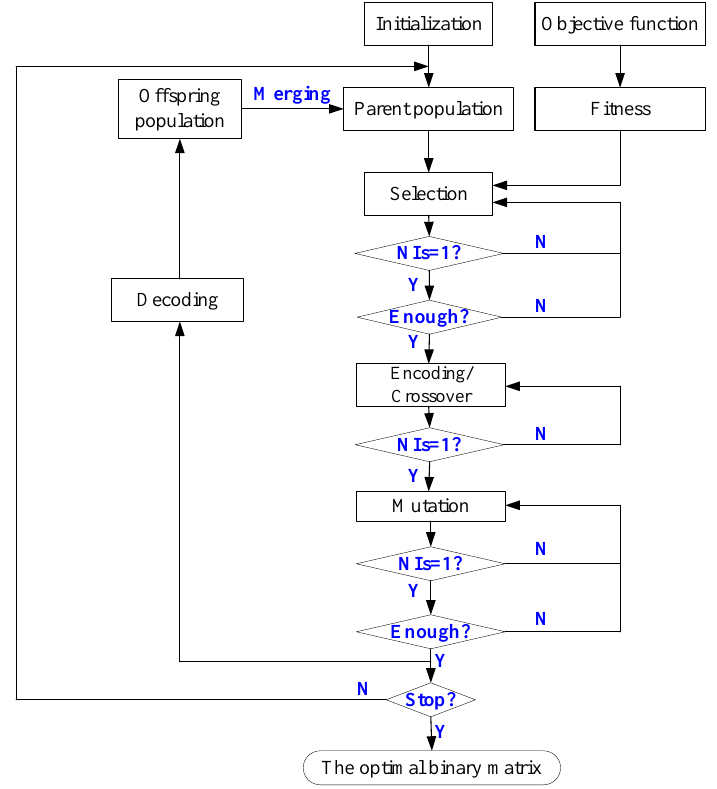
Figure 4. The binary-like topology optimization flowchart using the extended GA algorithm.